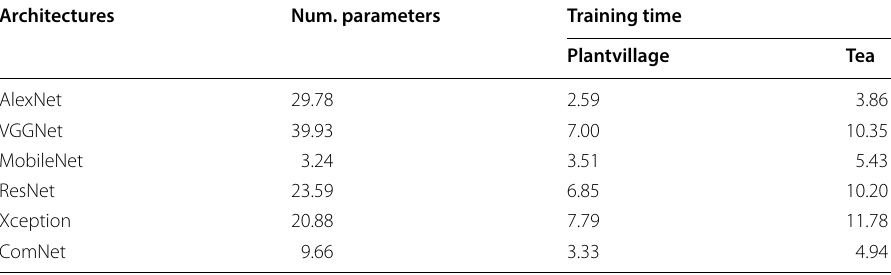
Table 4 The average accuracy of DCNN architectures